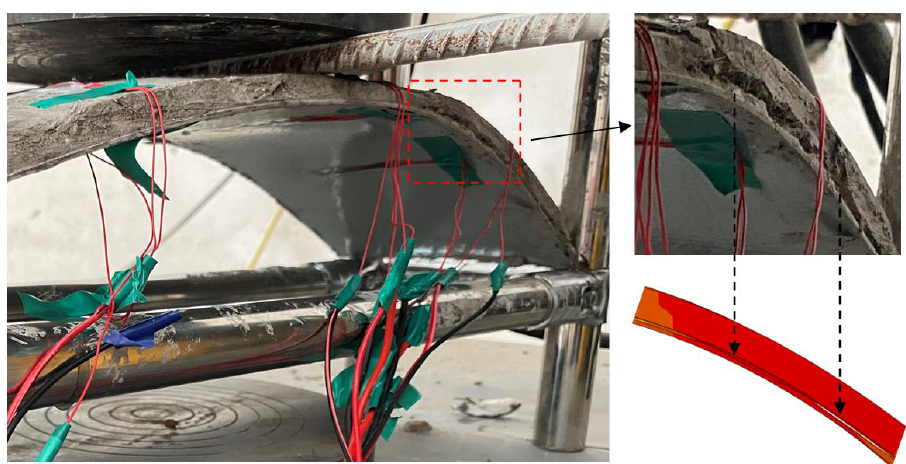
Figure 18. Debonding forms of experiments and simulation.